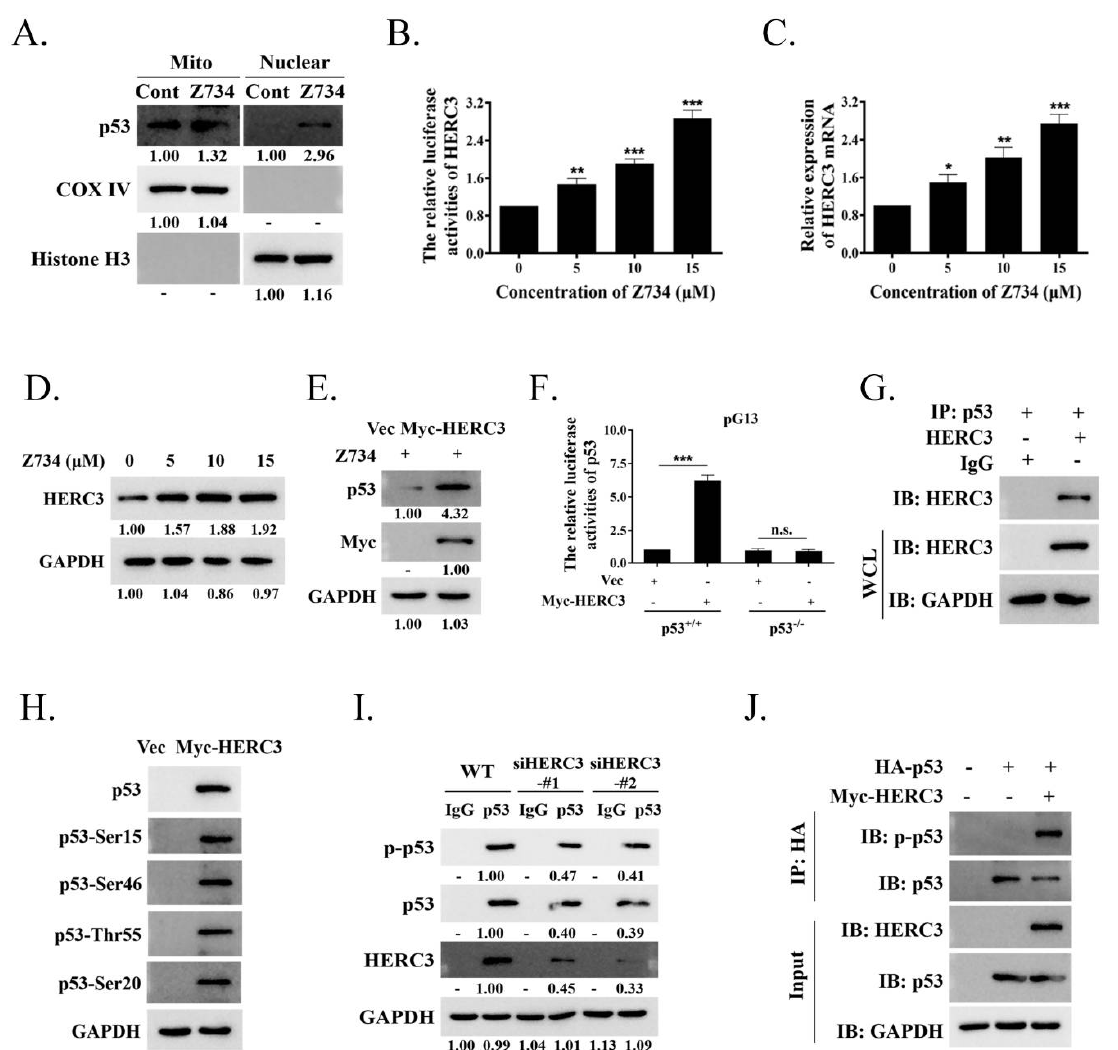
Figure 5. Z734–mediated HERC3 increasing promotes p53 level and p53 phosphorylation. ( A ) MCF–7 cells were treated with Z734 (10 µ M) for 12 h and then mitochondrial and nuclear fractions were prepared. The levels of p53 protein in the mitochondrial, cytosolic, and nuclear fractions were as- sessed by Western blotting. GAPDH, cytosolic loading control; COX IV, mitochondrial loading con-